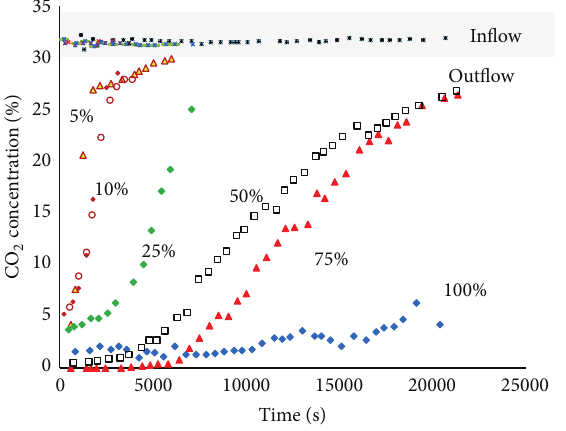
Figure 3: Evolution of CO 2 molar concentration at inlet and outlet of bubbler as function of aqueous MEA concentration.